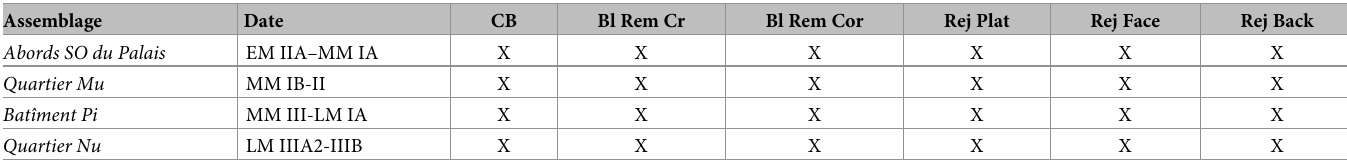
(b) The nature of production and products While pressure blade manufacture comprised the typical mode of consuming Melian obsidian amongst southern Aegean Bronze Age communities [113], there were regional, contextual, and chronological distinctions in how this knapping tradition was performed (e.g., modes of core preparation/rejuvenation, and blade initiation), and the size of their end-products [114]. In terms of length, the Maliote cores and blades are typically in the 4–5 cm range, comparable to what we see elsewhere in Crete, particularly during the 2 nd millennium BC [116, 131, 138, 140, 155]. The cores’ relatively short length implies that the pressure-flaked blades were likely removed using a simple hand-held tool, the nucleus being held in the other hand, or a simple clamping device [158]. While the Malia knappers sometimes initiated blade removal by using the natural edge of a rectangular nodule as a ridge for the fracture wave to follow (producing cortical blades), they mainly prepared artificial crests to start the process (Fig 9, 4–5), followed by a secondary series of laminar blanks with remnant cresting scars (Fig 9, 6). These modes of initiation are attested in Maliote assemblages throughout the Pre-, Proto-, Neo- and Final Pala- tial periods (Table 6), i.e., before and after the period of destruction and socio-cultural change. We can also consider the ways in which Maliote knappers maximised productivity through rejuvenating the blade core, actions that were usually required when the flaking angle between platform and face became difficult to control and led to mistakes, such as hinged or plunged Table 6. Modes of blade initiation and core rejuvenation detailed in Prepalatial to Final Palatial obsidian assemblages at Malia. CB = crested blade; Bl Rem Cr / Cr = blade with remnant cresting / cortex; Rej Plat / Face / Back = rejuvenation flake from core’s platform / face / back.